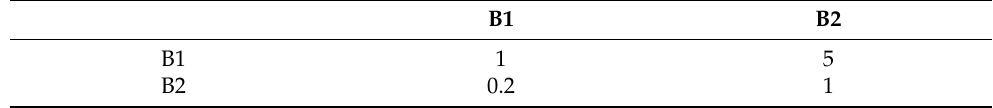
Table 6. B1–B2 importance judgment matrix.